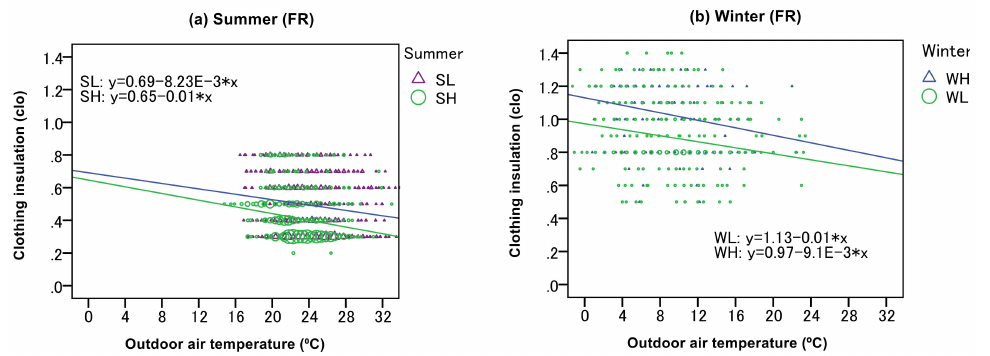
Figure 9. Clothing insulation and outdoor air temperature for higher and lower group: ( a ) Summer and ( b ) Winter.